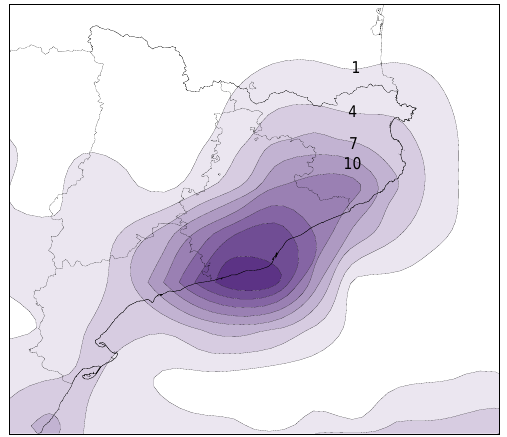
Figure 9. Waterspouts occurrence density contours in the period 1980-2009. Red inverted Fig. 9. Waterspouts occurrence density contours in the period triangles are the plotted waterspout in the period 1950-1979. The interval contours are 1 case/0.5ºx0.5º latitude longitude. 1980–2009. Red inverted triangles are the plotted waterspout in the period 1950–1979. The interval contours are 1 case/0.5 ◦ × 0.5 ◦ latitude longitude.